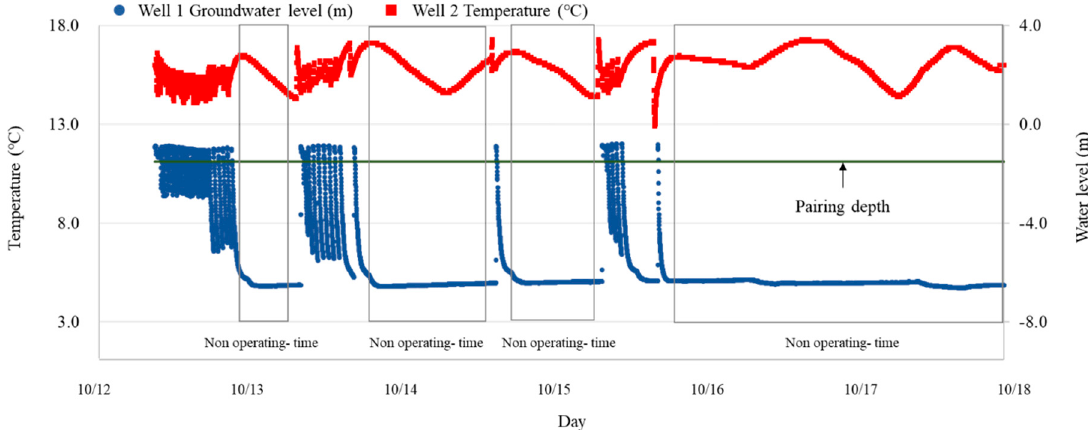
Figure 6. Supply well temperature and injection well groundwater level.